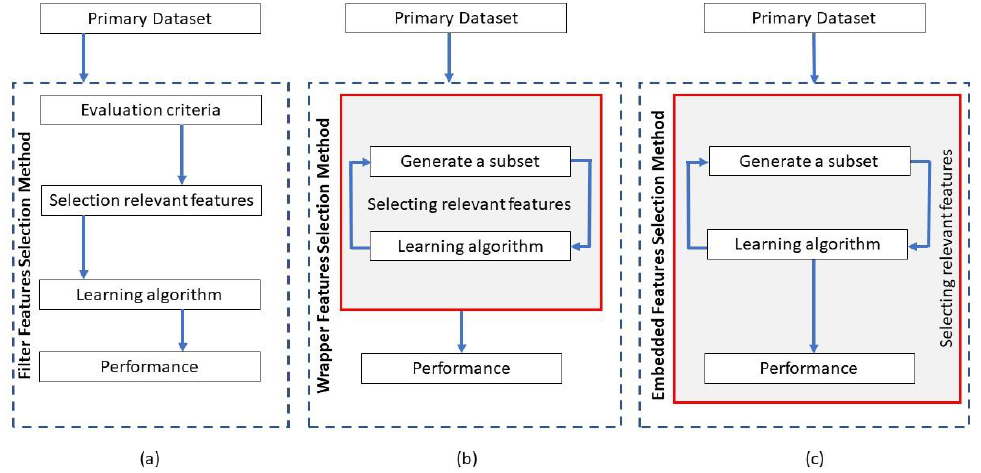
Figure 1. Information flow in the three primary categories of feature engineering methods: ( a ) filter, ( b ) wrapper, and ( c ) embedded methods [62].